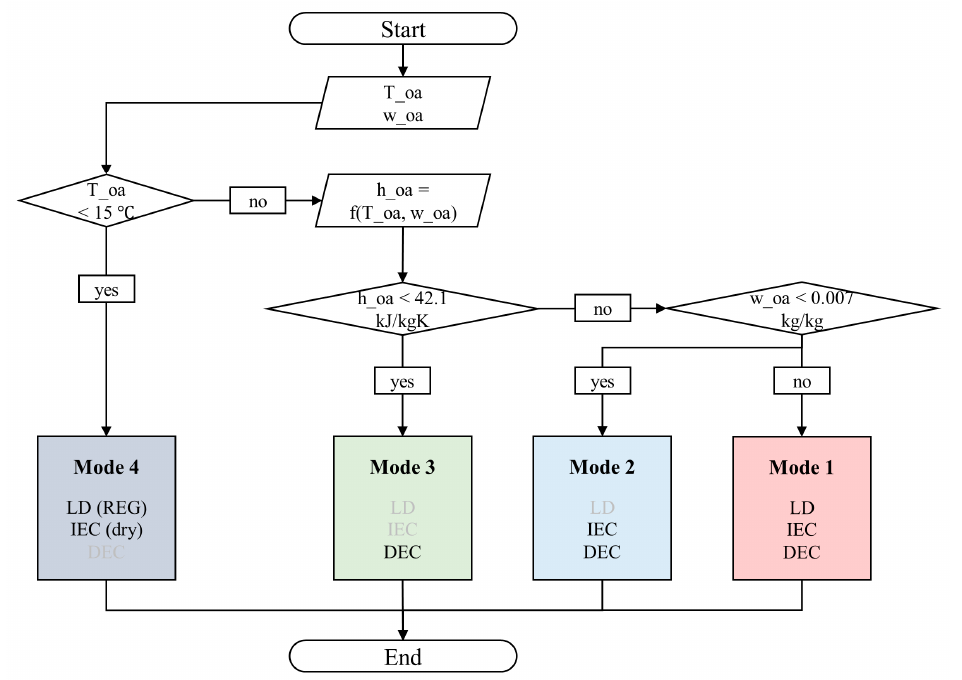
Figure 3. Mode of operation in the modified LD-IDECOAS. LD: liquid desiccant, REG: regenerator.